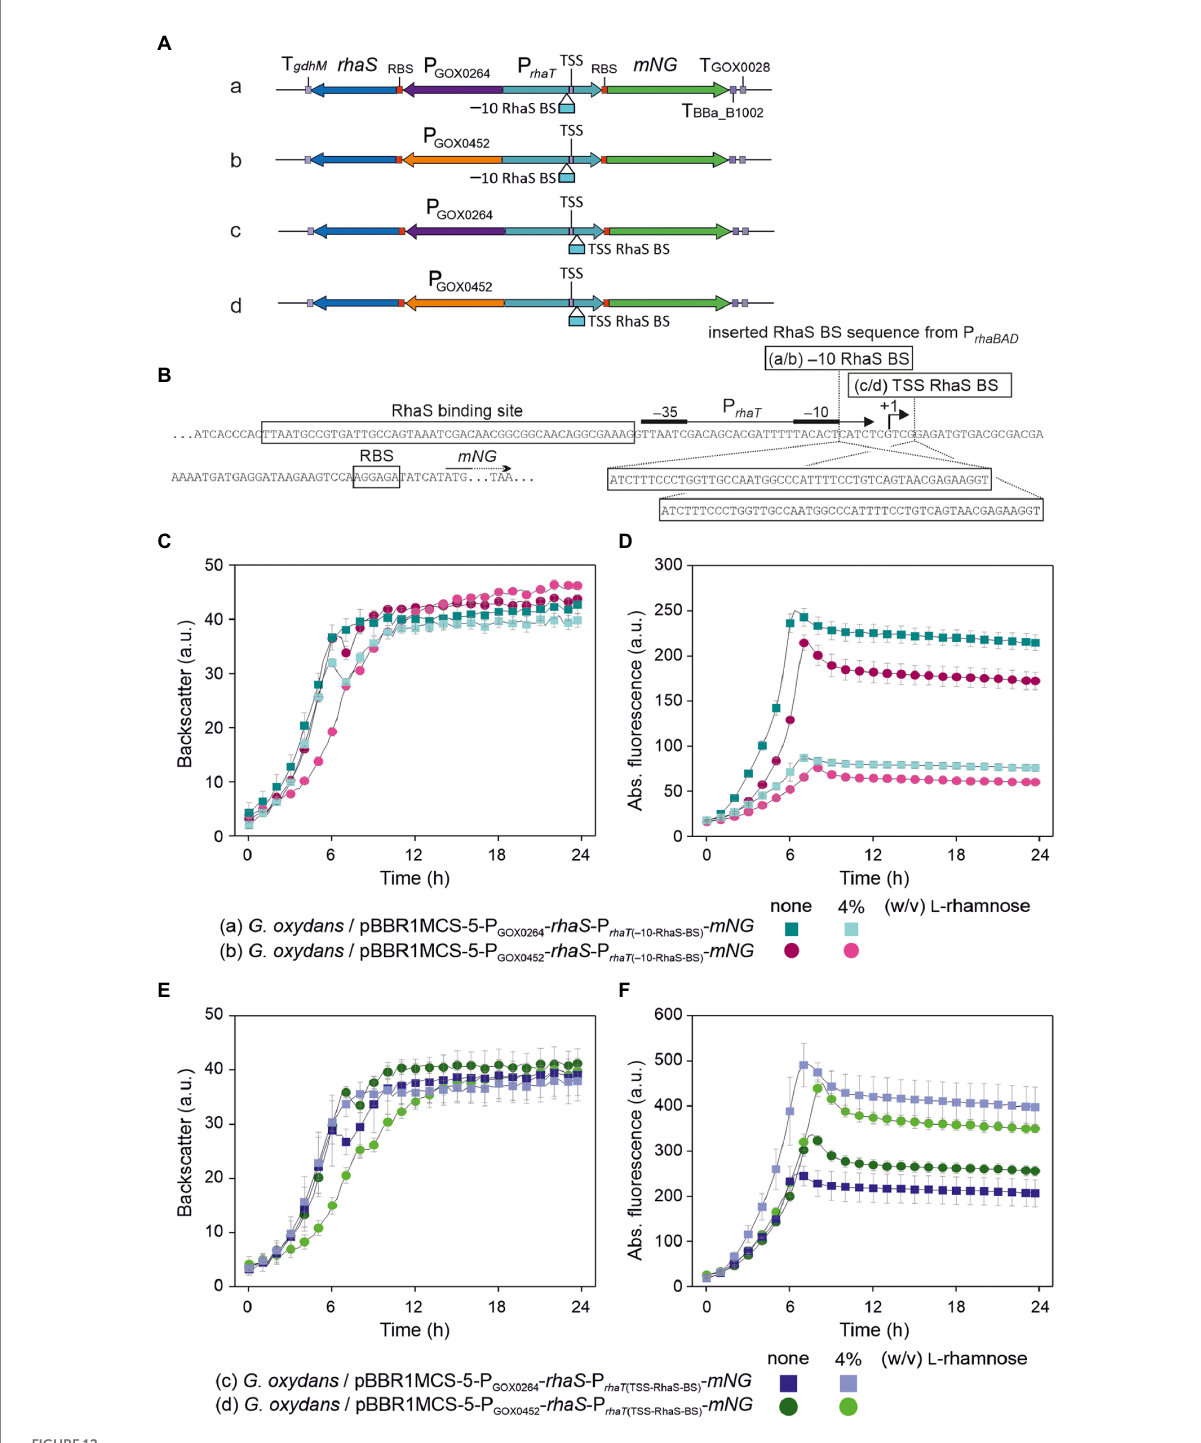
FIGURE 12 Insertion of an additional RhaS binding site directly downstream from the E. coli − 10 region of P rhaT reversed the regulation in G. oxydans making the modified RhaS-P rhaT system repressible in the presence of l -rhamnose. (A) Schematic illustration of the pBBR1MCS-5 plasmid inserts to test the effects of an additional RhaS binding site (RhaS BS) in P rhaT directly downstream from the E. coli − 10 region ( − 10 RhaS BS) or downstream from the E. coli P rhaT transcriptional start site (TSS RhaS BS) together with rhaS expression from P GOX0264 or P GOX0452 . (B) Sequence details of P rhaT with the positions and RhaS binding site sequence from P rhaBAD inserted either directly downstream from the E. coli − 10 region or downstream from the E. coli transcriptional start site (TSS +1) according to Vía et al. (1996). (C,E) Growth of the G. oxydans 621H strains with rhaS expression plasmid and modified P rhaT in d -mannitol medium according to backscatter and (D,F) absolute mNG fluorescence in BioLector cultivations. l -Rhamnose was supplemented as indicated. All data represent mean values and standard deviation from two biological replicates (clones) with three technical replicates each. BioLector settings: (C,E) backscatter gain 20, (D) fluorescence gain 60, (F) fluorescence gain